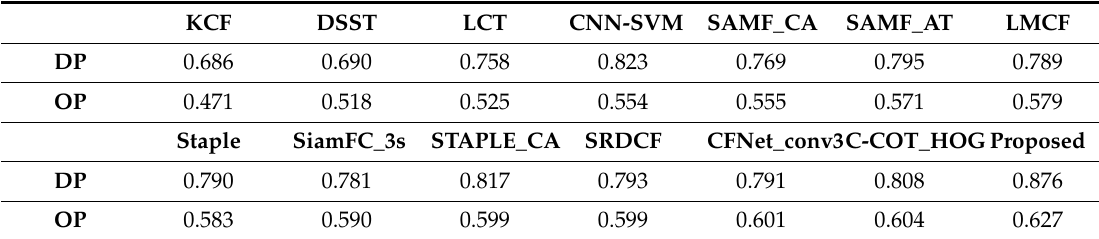
Table 3. Comparison with state-of-the-art trackers on the OTB dataset. The results are presented in terms of distance precision (DP) and overlap success precision